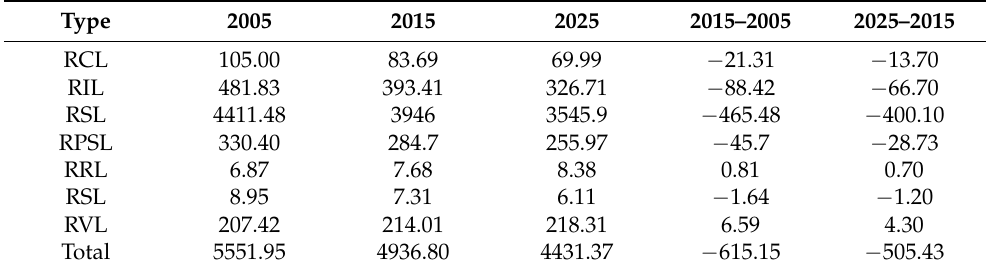
Table 3. Changes in the RSILUS in Pinggu District (ha).